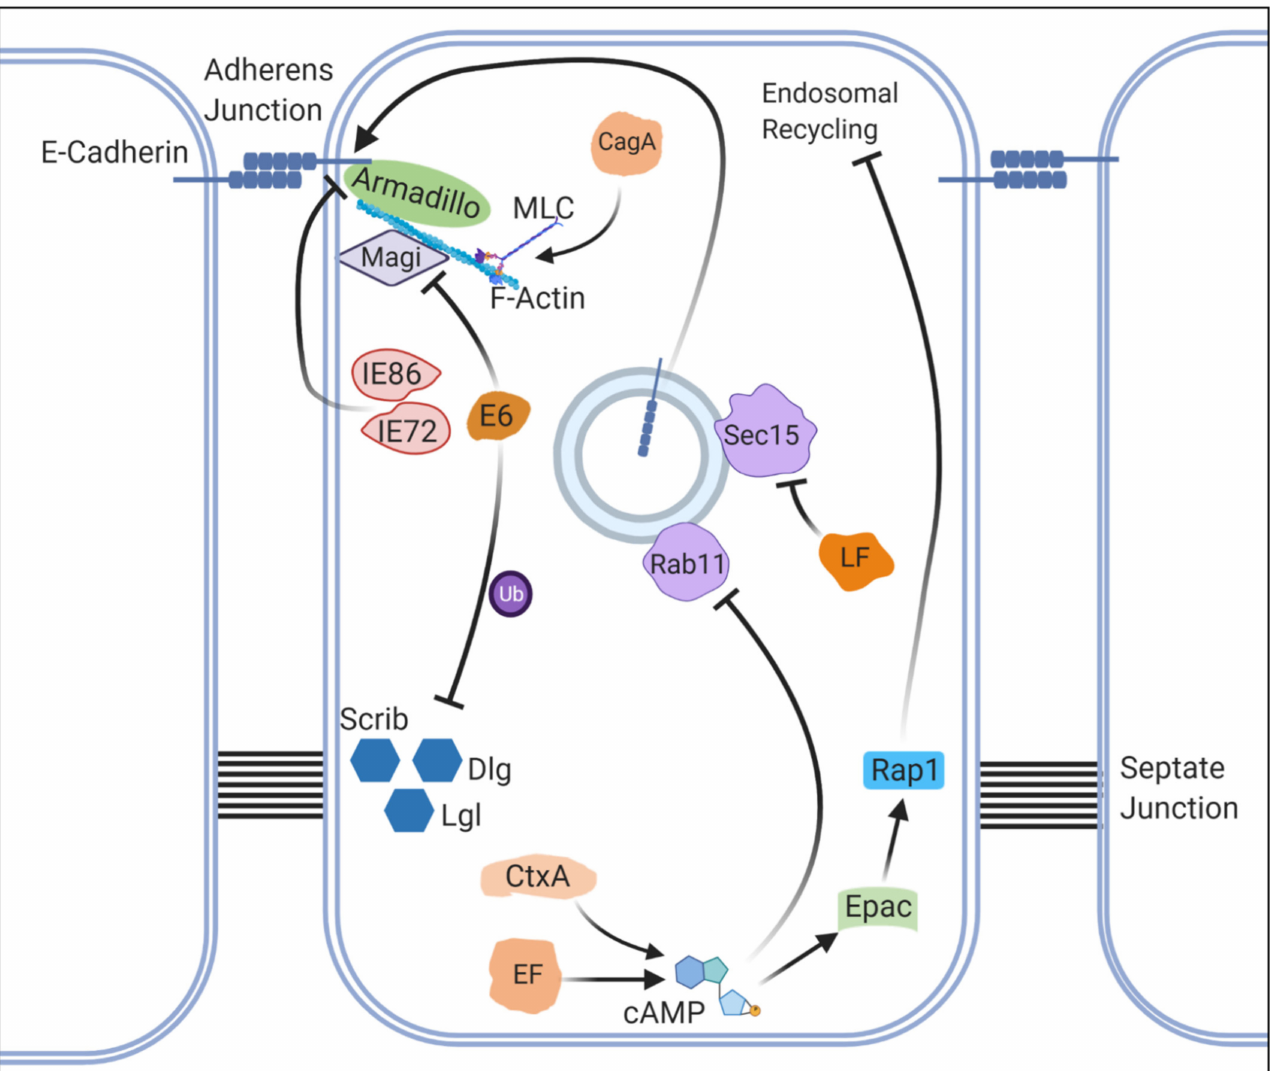
Figure 5. Virulence factors that affect cell adhesion or cytoskeletal proteins studied in Drosophila . Core proteins involved in cell adhesion are depicted along with pathogenic proteins that target these pathways. Host proteins shown in cool colors and pathogenic proteins (CagA ( H. pylori ), CtxA ( V. cholerae ), E6 (HPV), IE72/IE86 (HCMV), EF ( B. anthracis ), and LF ( B. anthracis )) are shown in warm